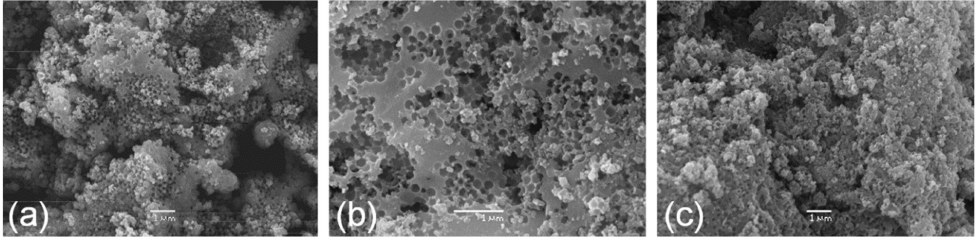
Figure 1. SEM analysis of samples TO2 ( a ), TO3 ( b ), and TO4 ( c